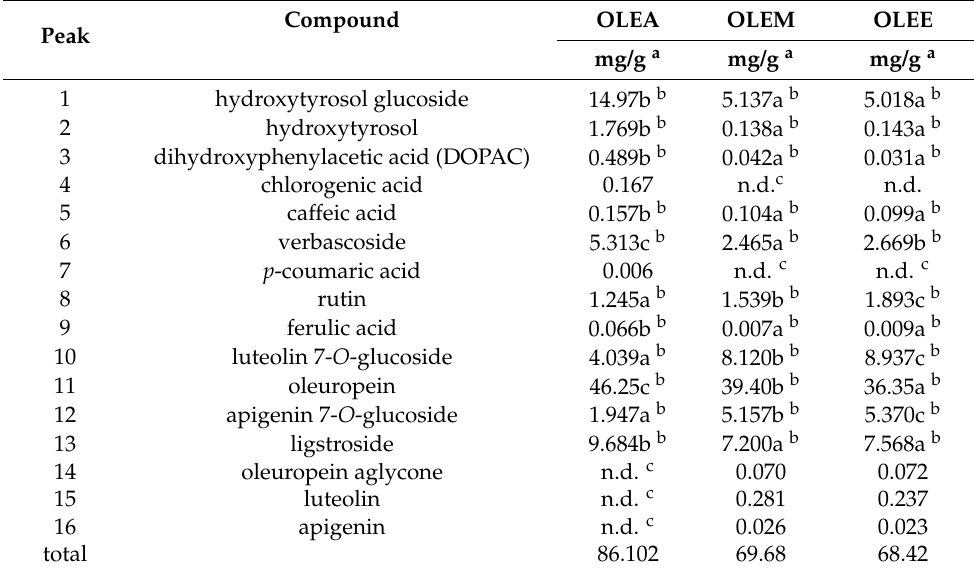
Table 5. Composition of olive leaf extracts obtained with different extraction mixtures.